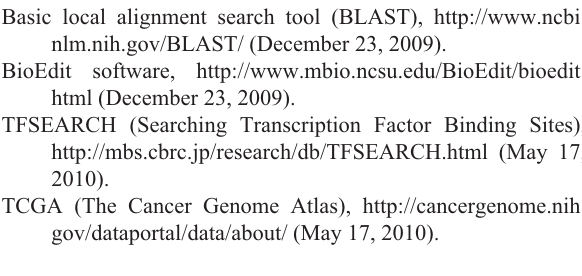
Figure S1 - Promoter polymorphisms of p16 INK4a at positions -1602, -871, -862 to -858, and -315. Figure S2 - Effects of the deletion of a region in the MDM2 pro- moter on luciferase activity in Colo320DM, U251, T98G, YMB-1, and HeLa cells. Figure S3 - A promoter polymorphism of p14 ARF at position -1477 in normal Japanese